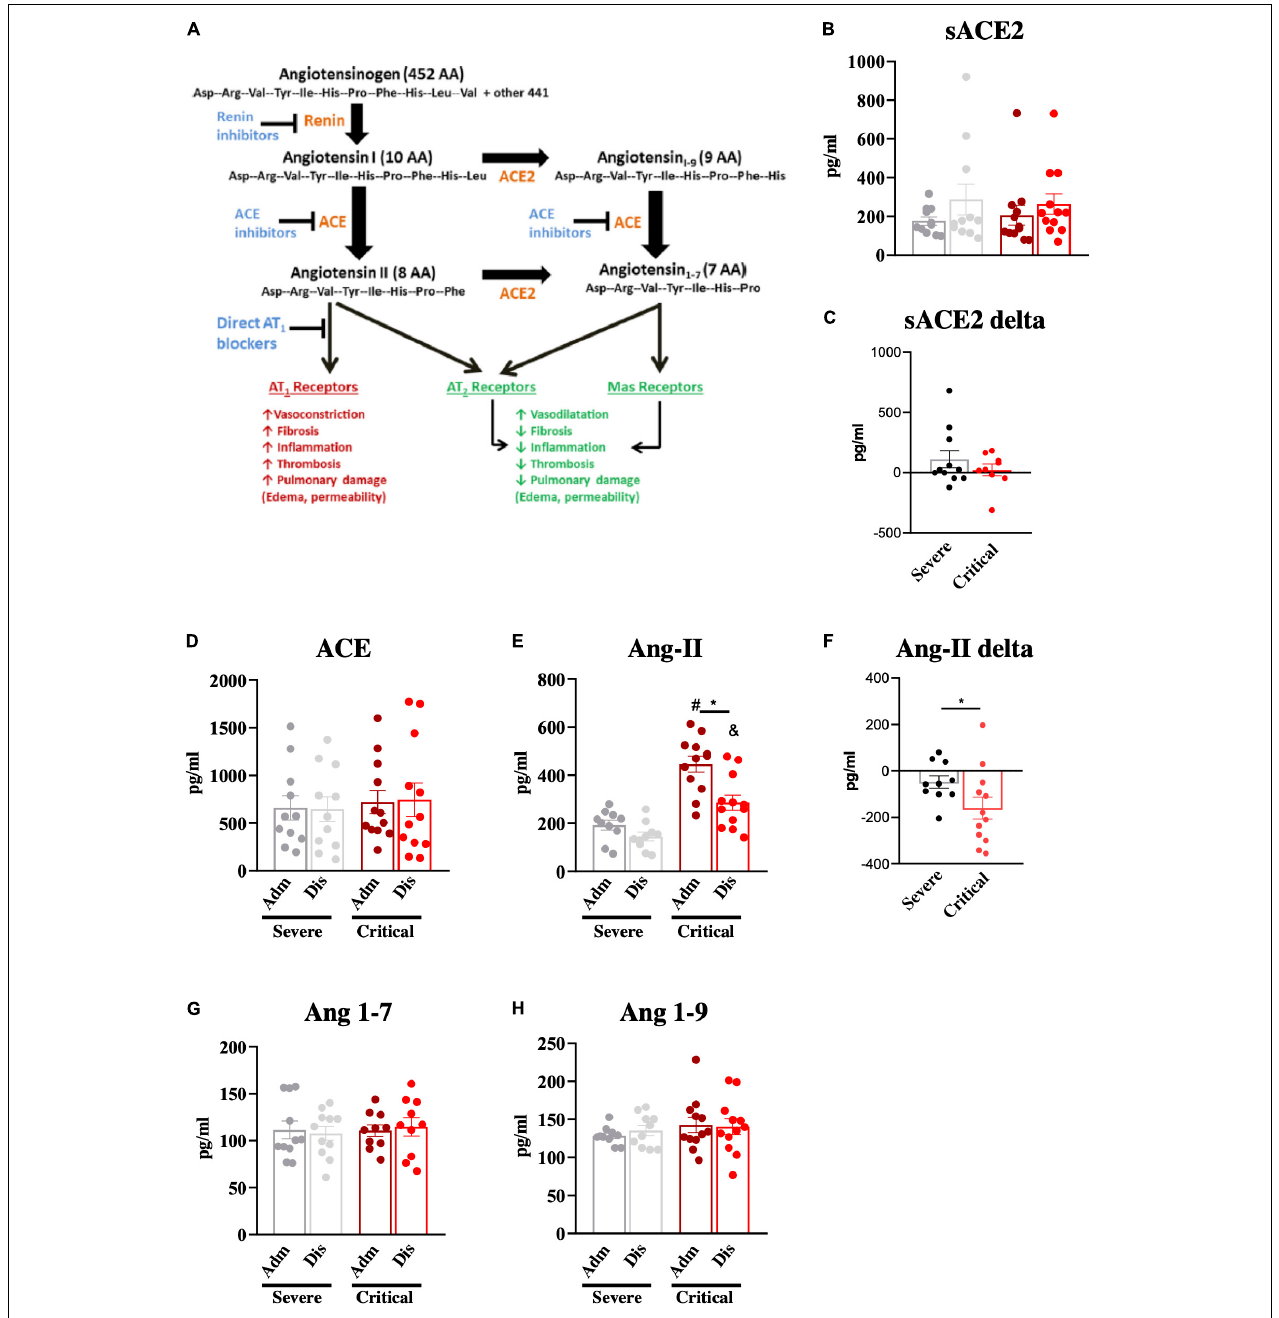
FIGURE 3 | Components of the renin-angiotensin-aldosterone system. The renin-angiotensin-aldosterone system and its main effects are depicted in (A) . Components of the renin-angiotensin-aldosterone system; soluble angiotensin-converting enzyme-2 (sACE2; B, C ), angiotensin-converting enzyme (ACE; D ), angiotensin-II (Ang-II; E, F ), angiotensin 1–7 (Ang 1–7; G ) and angiotensin 1–9 (Ang 1–9; H ) were determined in blood samples at hospital admission (Adm) and discharge (Dis). The variations of sACE2 (C) and Ang-II (F) from admission to discharge were determined. * p < 0.05; # p < 0.05 vs. severe at admission; & p < 0.05 vs. severe at